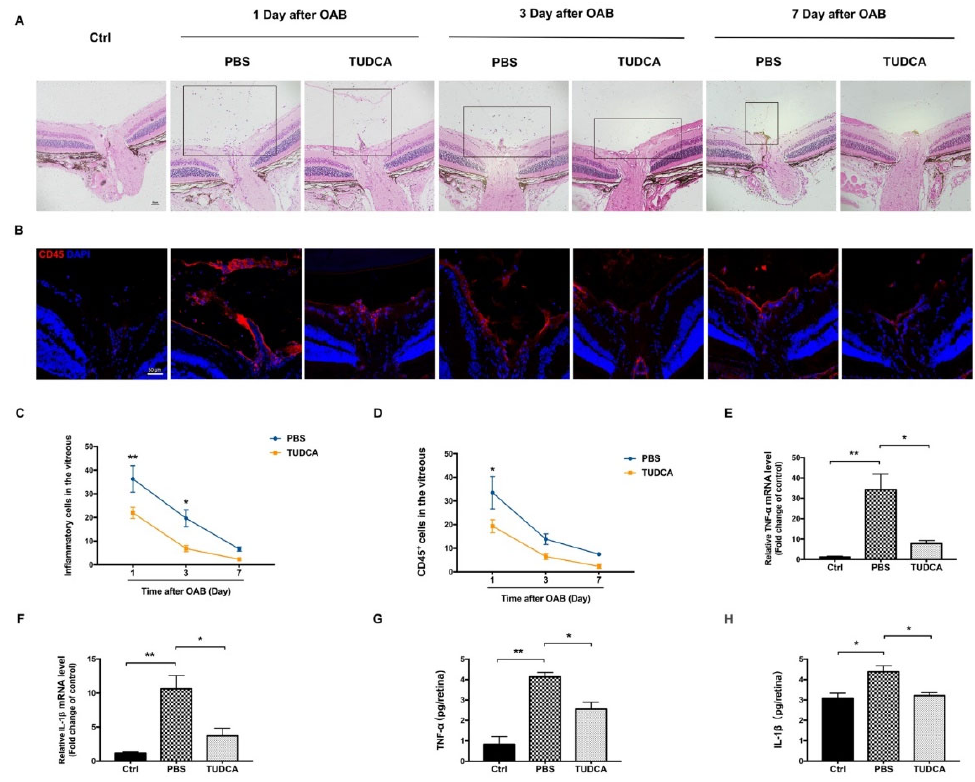
Figure 5. TUDCA reduces the retinal inflammation after OAB. ( A ) H&E staining of posterior segment of eyes in the control group, PBS ‐ treated group, and TUDCA ‐ treated group at 1, 3, and 7 days after OAB. ( B ) CD45 immunolocalization in different groups of retinas. ( C ) Quantitative analysis of inflammatory cells in the vitreous cavity in alkali injury eyes treated with PBS or TUDCA at different times ( n = 6 mice/group). ( D ) Quantitative analysis of CD45 + cells in the vitreous cavity ( n = 6 mice/group). ( E , F ) RT ‐ PCR analysis of the inflammatory cytokines TNF ‐α and IL ‐ 1 β in retinas harvested 1 day after OAB. ( G , H ) Protein levels of TNF ‐α and IL ‐ 1 β were analyzed by ELISA. Data are expressed as mean ± SEM ( n = 3, * p < 0.05, ** p < 0.01). Scale bar: 50 μ m. Ctrl, control; OAB, ocular alkali burn; TUDCA, tauroursodeoxycholic acid.